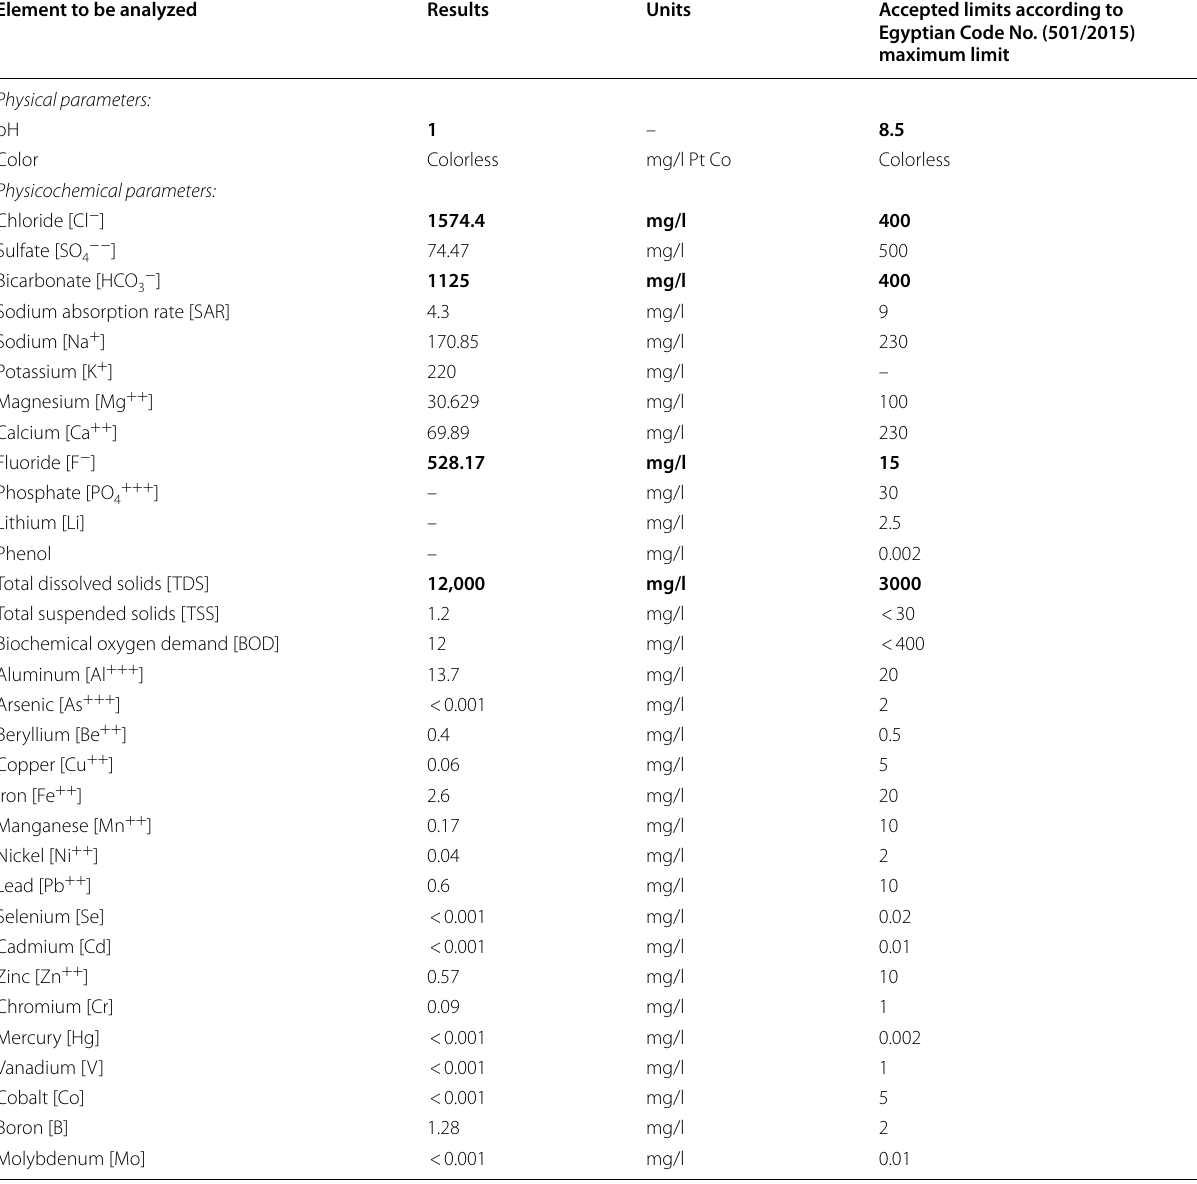
Bold are indicates the high levels of pollutants